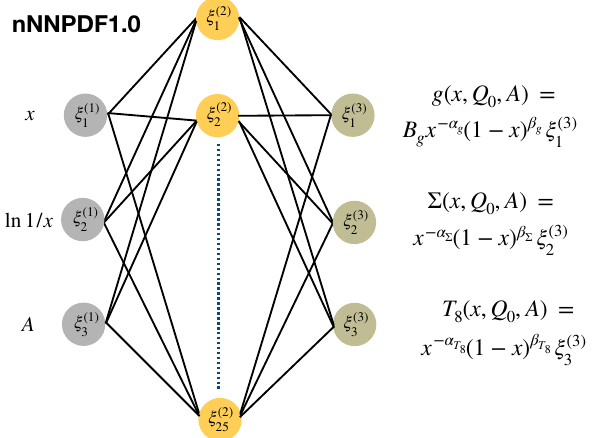
Fig. 4 Schematicrepresentationofthearchitectureofthefeed-forward neural network used in the nNNPDF1.0 analysis to parameterize the x and A dependenceof (cid:12) , T 8 ,and g attheinitialscale Q 0 .Thearchitecture is 3–25–3, where the values of the three input neurons are x , ln 1 / x , and A , and the values of the output layer neurons correspond to the input nPDFs: g ( x , Q a , A ) , (cid:12)( x , Q 0 , A ) , and T 8 ( x , Q 0 , A ) . For the input and hidden layer, a sigmoid function is used for neuron activation, and a linear activation is used for the final output layer